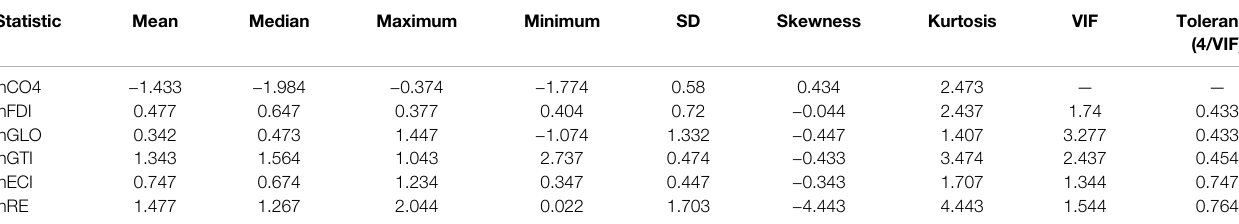
TABLE 1 | Descriptive statistics.